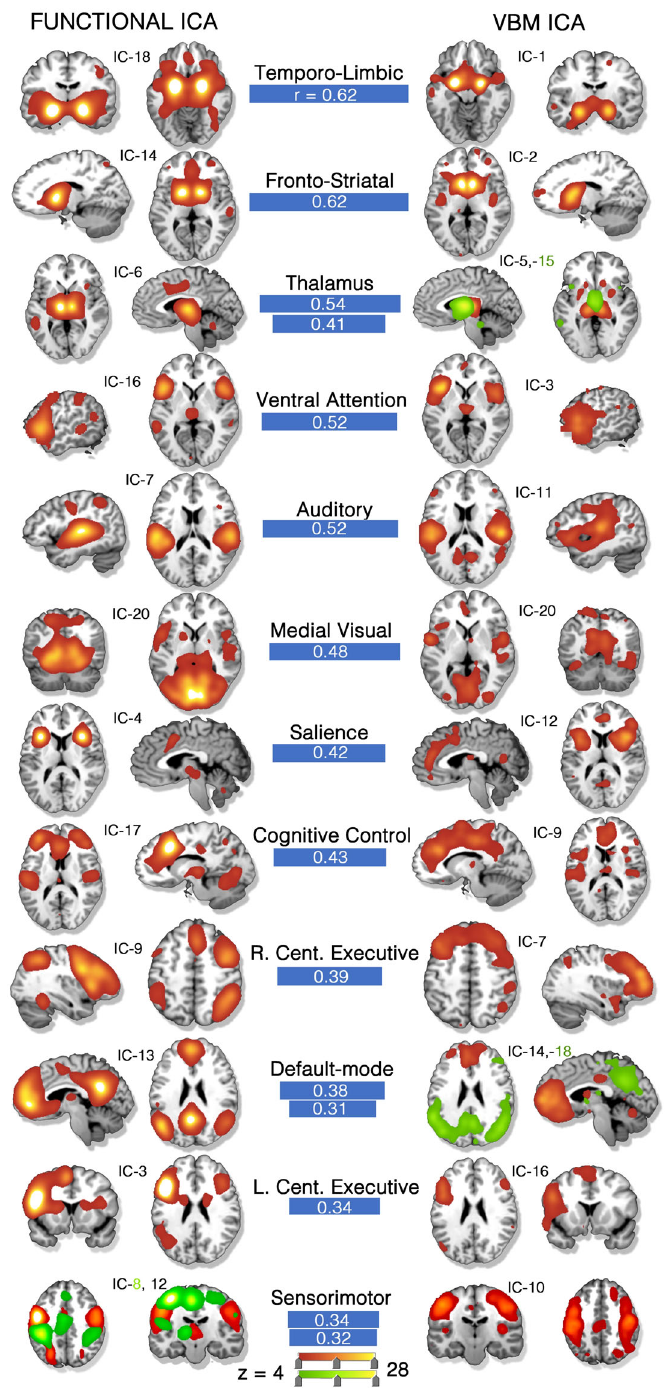
Fig. 1 Co-alteration and task-activation network correspondence ( d = 20). (Left) Thirteen task-activation (TA) networks derived from the BrainMap-TA sector ( n = 7865 task-activation experiments among healthy subjects). (Right) Fourteen structural co-alteration networks derived from the BrainMap voxel-based morphometry sector ( n = 2002 experiments across n > 40 diseases). Clear network matches across datasets are shown by blue connecting bars, the width of which are proportional to the whole-brain, spatial correlation coef fi cient. Some networks matched to two, separate opposite-modality networks (red and green). Color scale is shown at the bottom of the image. Independent component (IC) numbers are ordered by explained variance within the respective dataset. All component matches are at or below a signi fi cance threshold of p = 0.01, family-wise error (FWE) rate corrected. Source data are provided in Supplementary Data Informational comparison . Among matched networks, a linear 70/70) as opposed to off-diagonal comparisons (e.g., 20/45). The regression was indeed found to be signi fi cant between disease upper diagonal, where higher VBM dimensions were compared to (independent variable) and behavior network-normalized entropy lower functional dimensions, showed more matches (mean among all matched networks [ β = 0.60 (std. error: 0.147); 57.3%) compared to the lower diagonal (mean 49%).